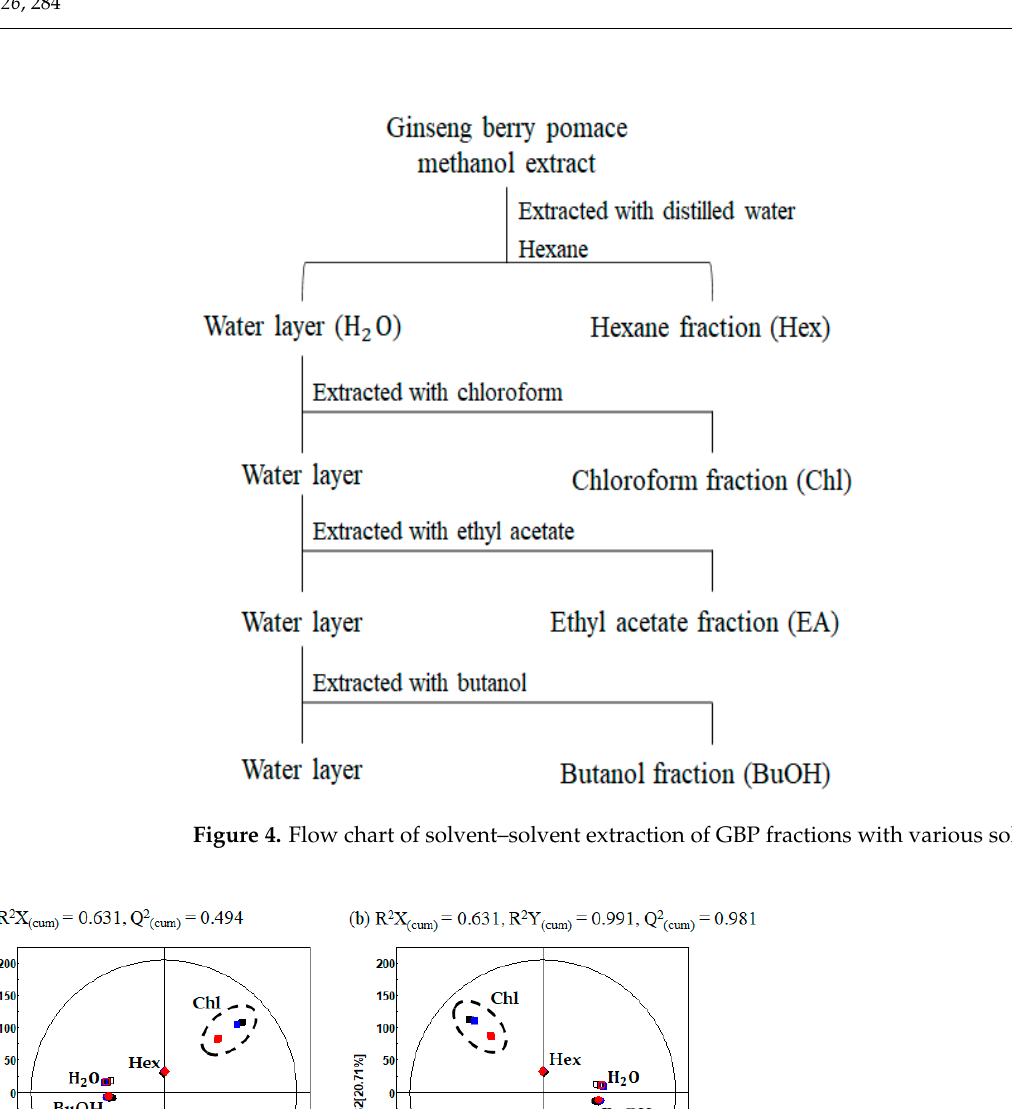
Figure 6. Heatmap analysis in five different solvent fractions of GBP samples derived from UHPLC-LTQ-Orbitrap-MS/MS data. The heatmap indicates the relative contents in secondary metabolites among different fractions. In this analysis, significantly discriminant metabolites were determined (VIP > 0.7 and p < 0.05).